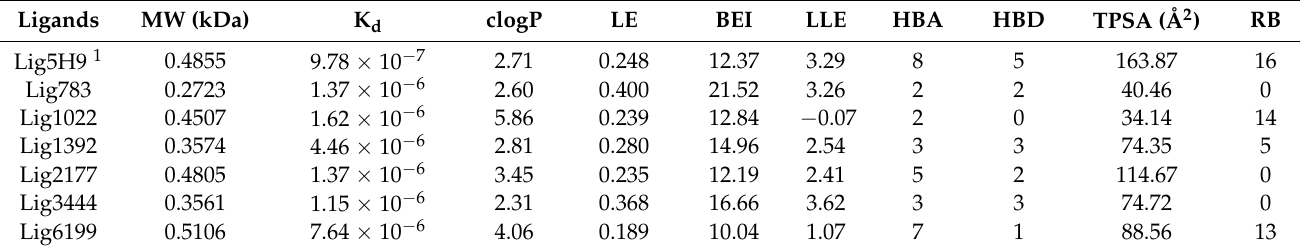
Table 4. Ligand efficiency parameters calculated and absorption, distribution, metabolism, excretion, and toxicity (ADME- Tox) properties prediction for all molecules studied. Ligands MW